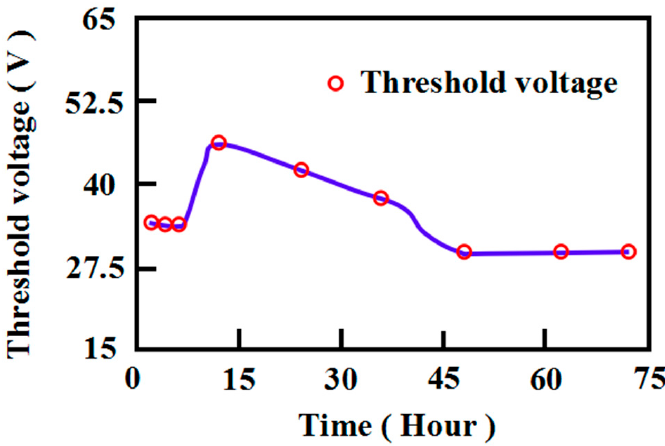
Figure 12. Relationship between threshold voltage and measurement